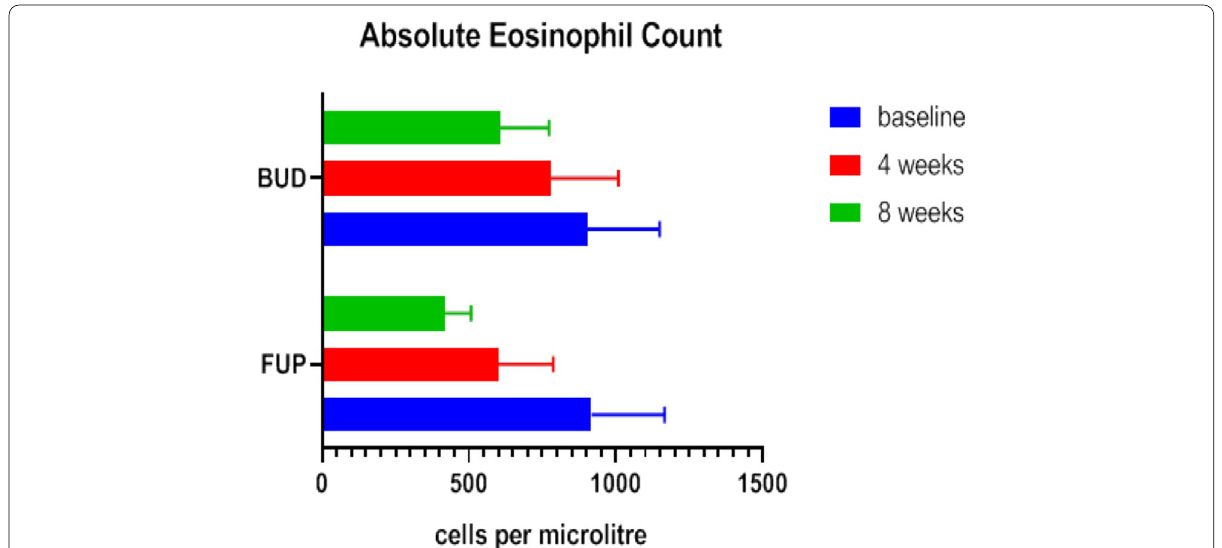
Fig. 4 A Comparing the efficacy of intravitreal ranibizumab from baseline to 6 months in reducing central foveal thickness. B Comparing the efficacy of intravitreal triamcinolone from baseline to 6 months inreducing central foveal